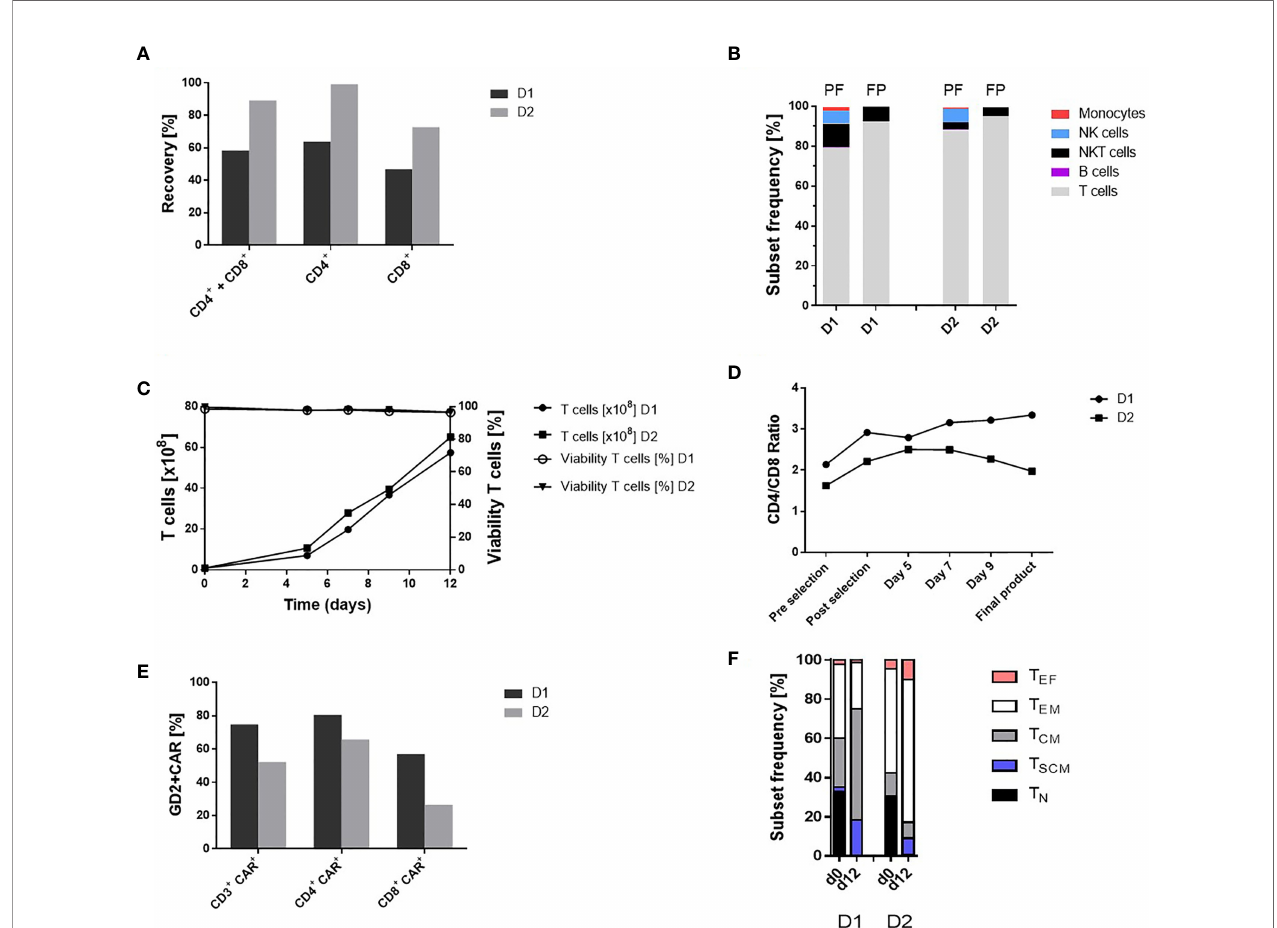
FIGURE 2 | Automated GMP-compliant manufacturing of IL-18 TRUCKs targeting GD 2 using the CliniMACS Prodigy ® (clinical-scale process). (A) Recovery (cell population in percent of cell population pre-enrichment) of CD4 + and CD8 + cells after enrichment. (B) Cell composition after enrichment of CD4 + and CD8 + cells and in the fi nal products. The achieved T cell purity in the positive fraction (PF) was 79.1% D1 and 87.7% D2 with contaminating CD56 + CD3 + NKT cells (12.0% D1 and 3.8% D2), CD56 + CD3 - NK cells (6.4% D1 and 6.8% D2), CD14 + monocytes (1.9% D1 and 0.6% D2) and CD20 + B cells (0.2% D1 and 0.5% D2). Cell composition of the fi nal products (FP) with a purity of 92.1% D1 and 95.0% D2 T cells (CD3 + /CD56 - ) and impurities with NKT cells (7.6% D1 and 4.4% D2) as well as residual 0.1% D1 and 0.2% D2 NK cells. Residual B cells (0.05% D2) were detected but no monocytes in the fi nal products. (C) Expansion and viability of T cells (CD3